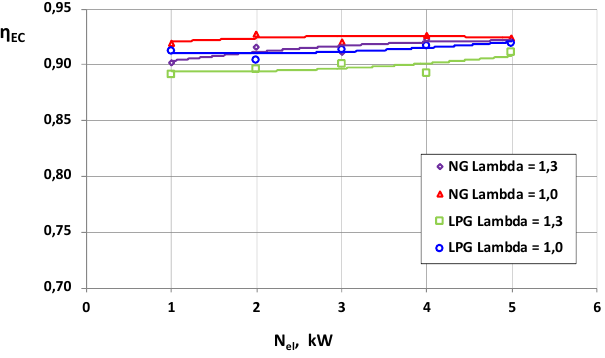
Fig. 10. Total efficiency of mCHP unit vs output electric